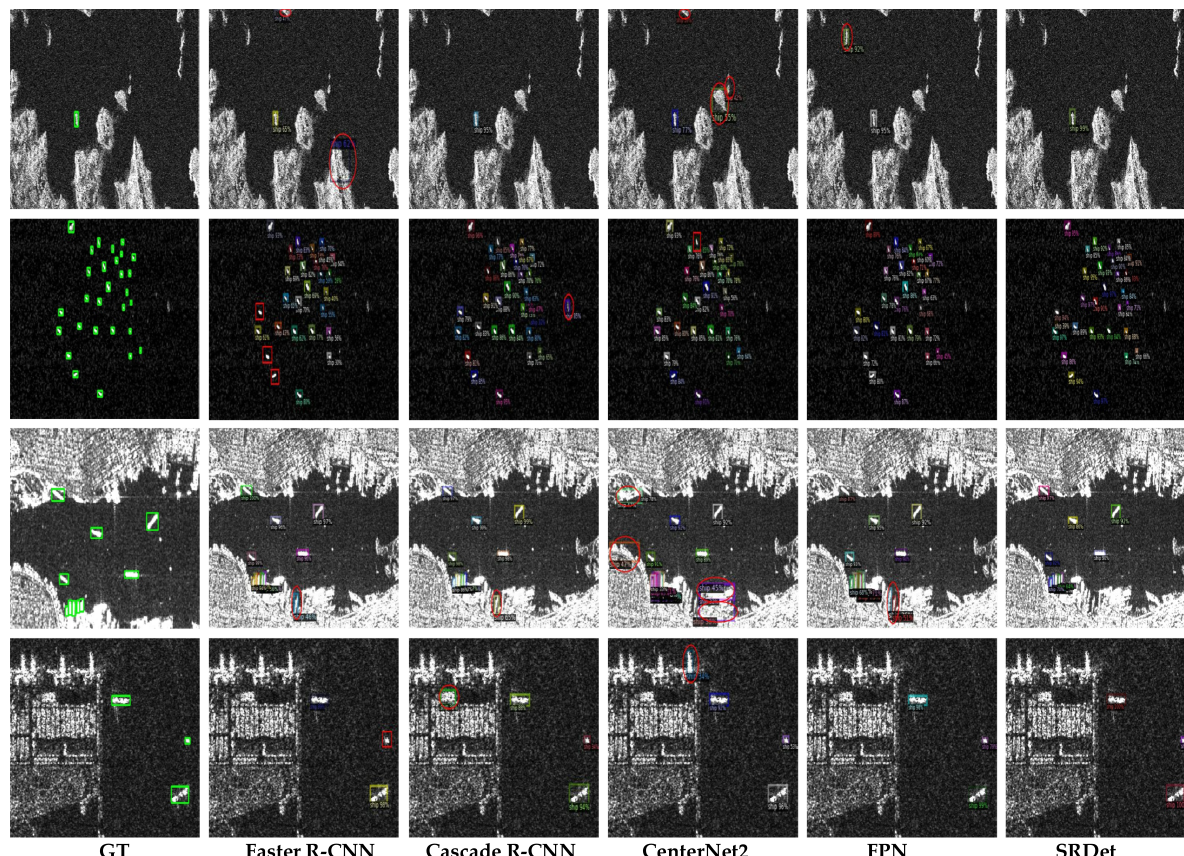
Figure 11. Visual comparison with two-stage object detection algorithms. Comparison results of five different methods on SSDD, GT stands for ground truth.